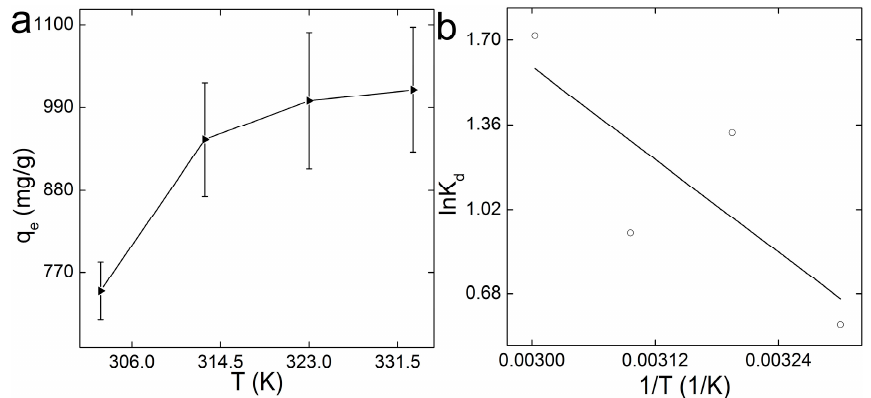
Figure 5. Thermodynamics analyses of the adsorption of MB on GO-COOH sponge. ( a ) Adsorption as a function of contact temperature. Data represent mean ± SD ( n = 3). ( b ) Thermodynamic analysis. Table 3. Thermodynamics parameters of the adsorption of MB on GO-COOH sponge.